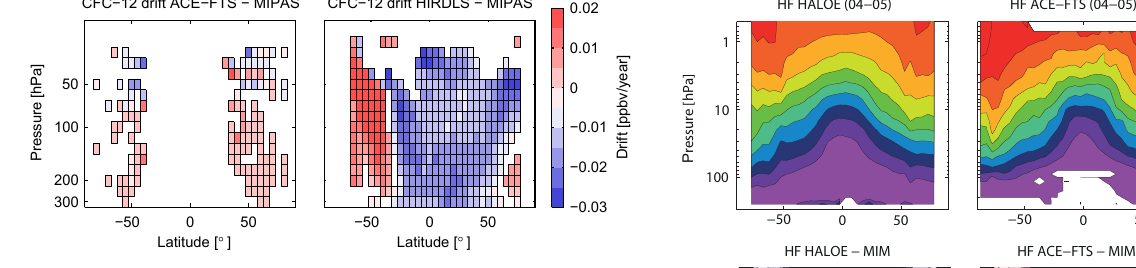
Figure 7. Altitude–latitude cross sections of drifts between ACE- FTS and MIPAS (left panel) and HIRDLS and MIPAS (right panel) CFC-12 climatologies are given in form of the linear terms [ppbvyear − 1 ] derived from multi-linear regression of the difference time series.